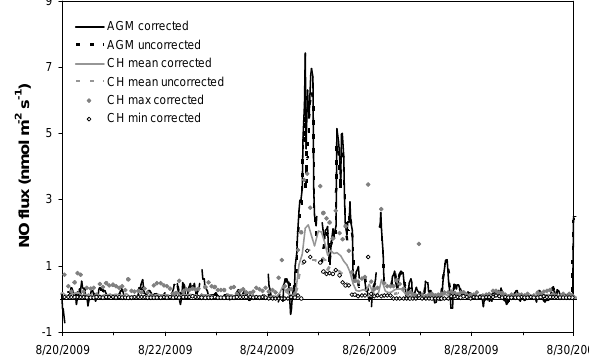
y = 1.0109x - 0.382 R 2 = 0.7304